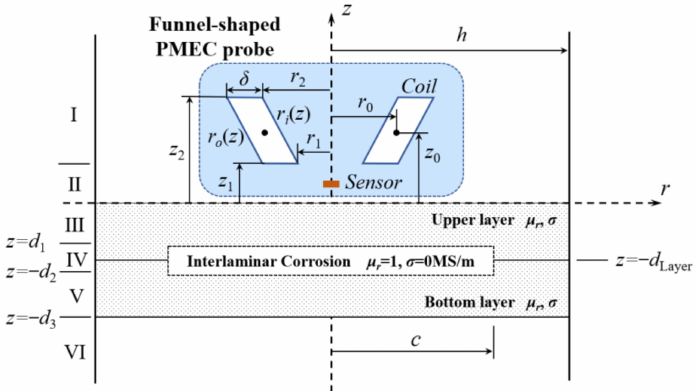
Figure 1. A 2D axisymmetric model of a funnel-shaped PMEC probe placed over a two-layer stratified conductor with an ILC at the interface between the upper and bottom